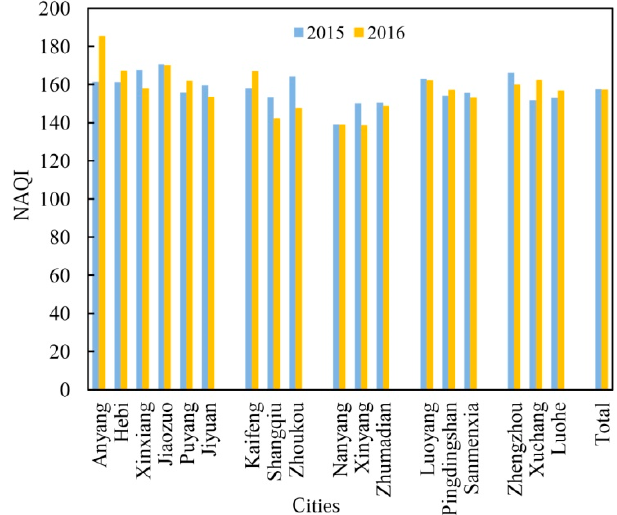
Figure 2. Variations in annual average air quality index (AQI) on non-attainment days at the city and province scales in